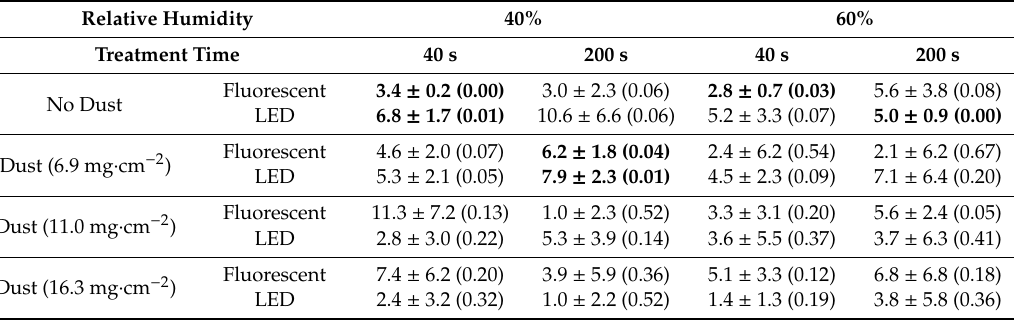
Table A10. N 2 O mitigation under the di ff erent dust levels at a relative humidity of 40% and 60% in photocatalysis. Values in the table report % reduction ± standard deviation ( p -value) and are an average between treatments of NH 3 and H 2 S standard gases. Bold font signifies statistical